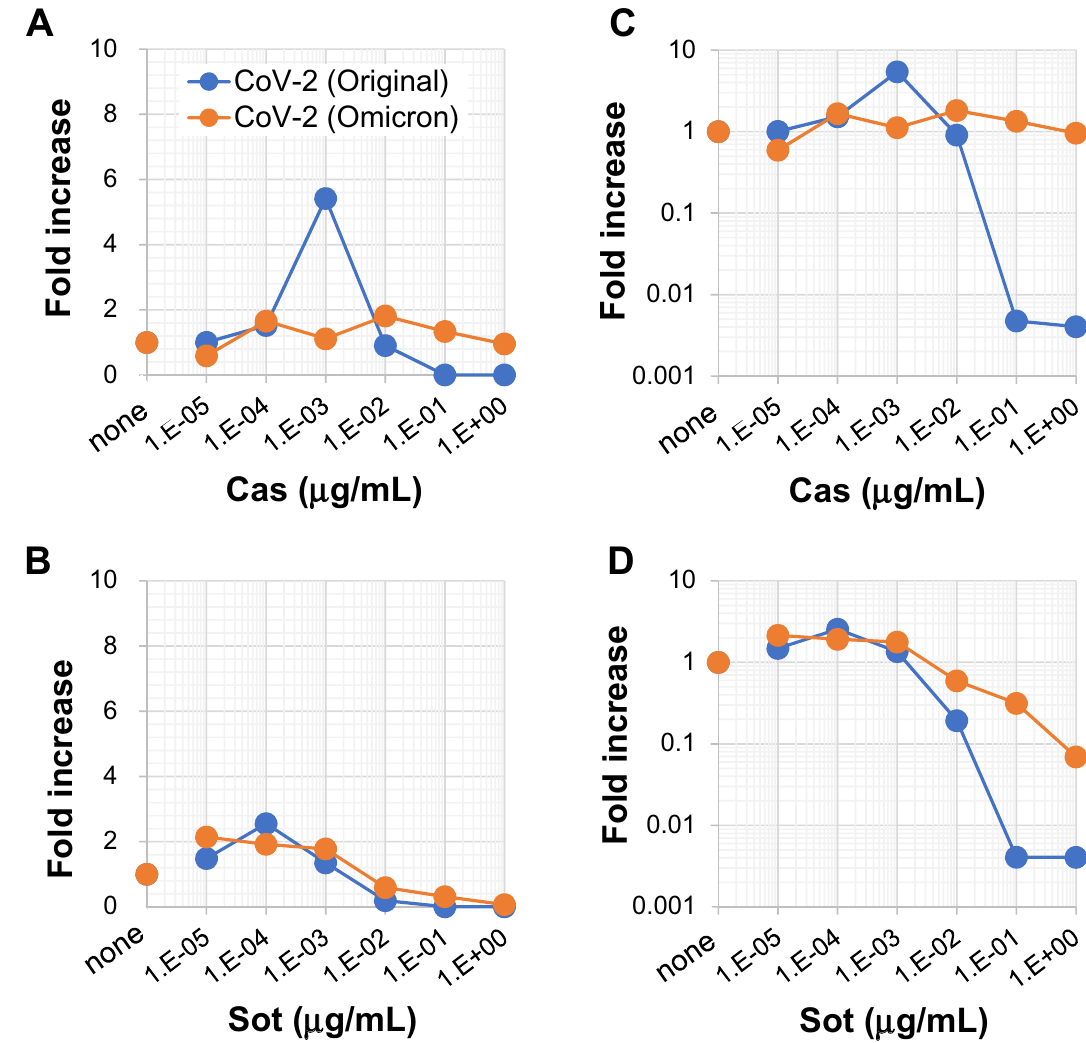
Figure 2. Sotrovimab mAb has no potential to cause ADE of infection. Clone 35 cells (2 × 10 4 /well in a 96-well flat plate) were cultured with SARS-CoV-2 (original or Omicron strain) in the presence (N = 3) or absence (N = 3–6, control culture) of serially-diluted Cas ( A , C ) or Sot ( B , D ) mAb. Three days later, the amount of virus in culture SNs was measured by qPCR. The increase of virus progeny in SNs is expressed as the fold increase compared with the amount of viruses cultured in the absence of mAb on a linear scale ( A , B ) or log scale ( C , D